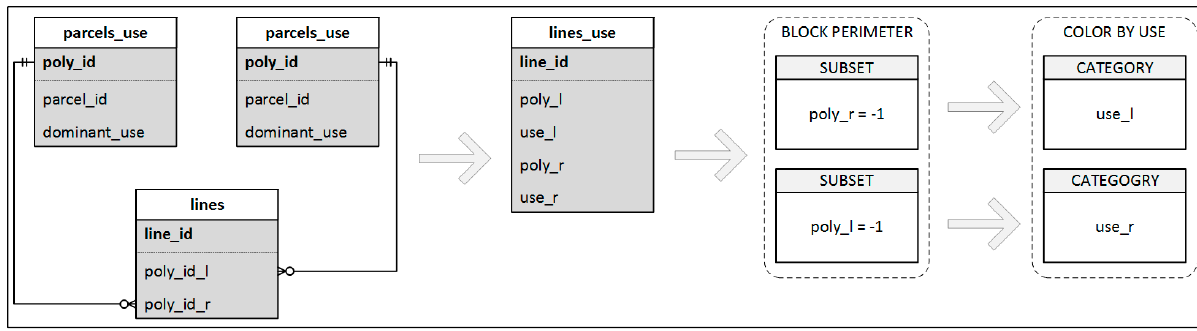
Figure 10. Diagram of the process to assign the parcel dominant use to its façade(s).